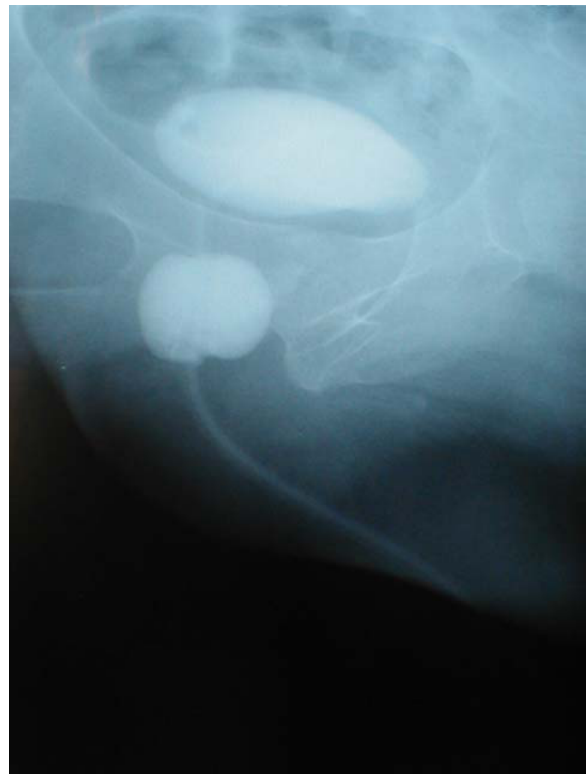
FIGURE 1. X-ray of pelvis is taken after injecting 30 ml of sterile nonionic X-ray contrast medium, Ioversol, through the main lumen of the Foley catheter (for visualizing the urinary bladder) and 3 ml of Ioversol through the side channel. Injecting contrast medium through the side channel enables visualization of the balloon of the Foley catheter. The round opaque shadow, which is located below the urinary bladder, represents the balloon of the Foley catheter. The Foley catheter can be seen as it traverses the distal urethra because the catheter is delineated by the radio-opaque contrast medium within its lumen. This radiological study takes less than 5 min to perform and clinches the diagnosis that the balloon of the Foley catheter is located in the urethra, an invaluable aid in planning future treatment and settling malpractice